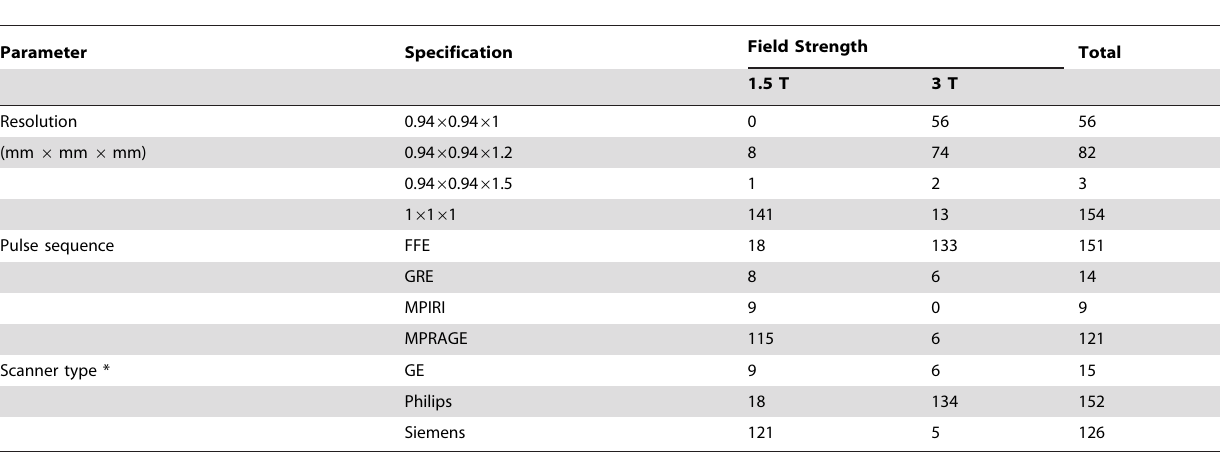
Table 2. Sample distribution based on image resolution, pulse sequence and scanner manufacturer